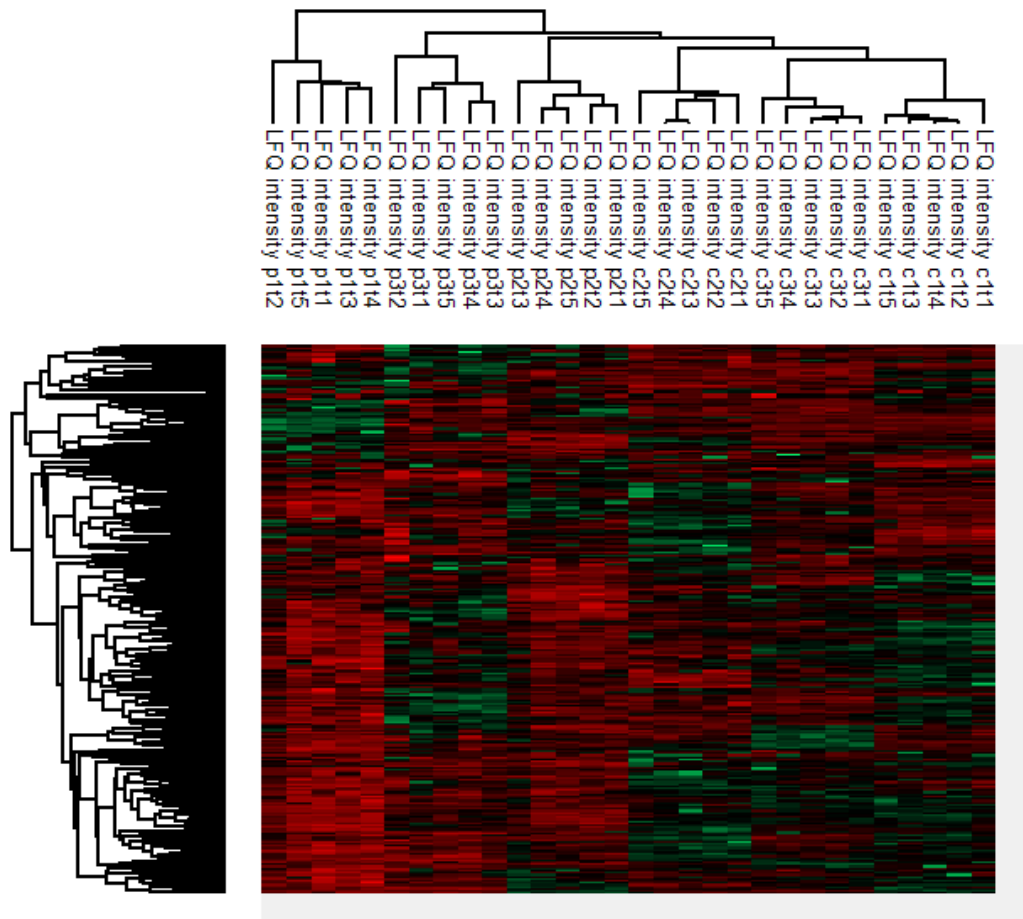
Figure 1. Heatmap combined with unsupervised hierarchical clustering based on z-score normalized LFQ intensities. Five longitu- dinally acquired serum samples of six individuals (three cases, three controls) were included. The high level of individual clustering indicates that intrapatient differences in protein levels ask for longitudinal sampling to detect subtle differences. c # = number of the control followed by the sequential time of blood draw; p # = number of the patient followed by the sequential time of blood